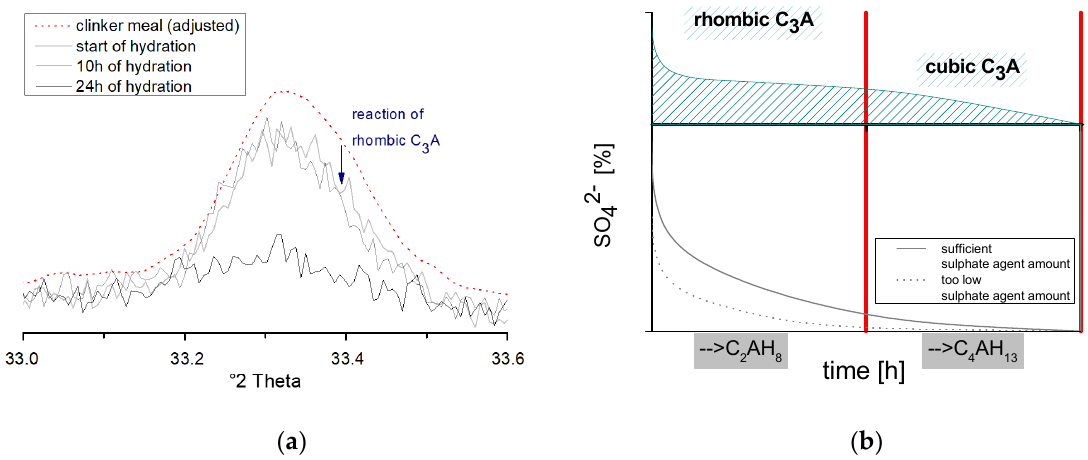
Figure 11. XRD development of C 3 A peak within 24h of hydration ( a ) and schematic development of cubic and rhombic C 3 A ( b